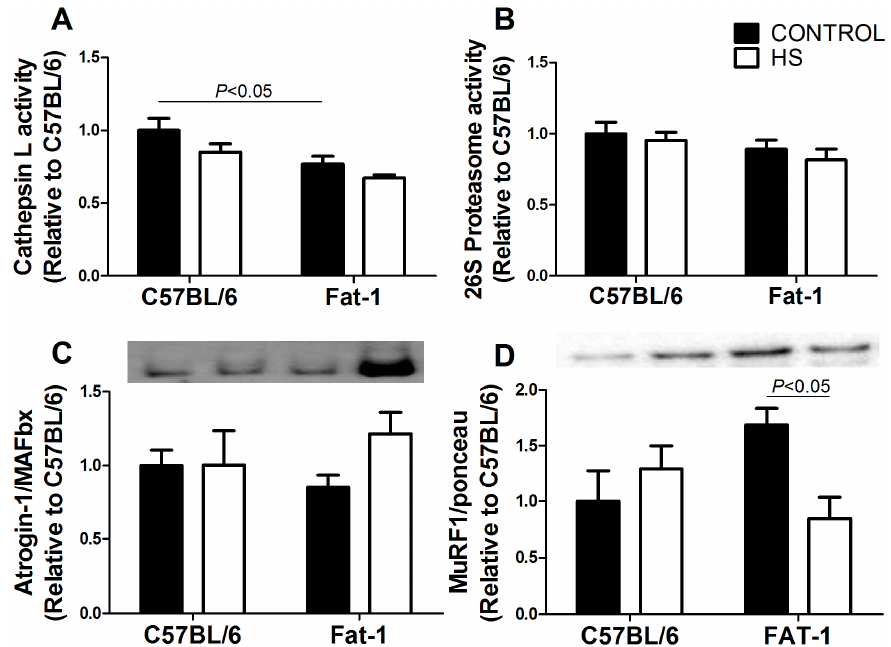
Figure 3. ( A ) Cathepsin L activity in the gastrocnemius muscle of the four groups studied (C57BL/6, C57BL/6 + HS, Fat-1, Fat-1 + HS). ( B) 26S proteasome activity in the gastrocnemius muscle. ( C ) atrogin-1/MAFbx and D. MuRF-1 content in soleus muscle. Values are presented as mean ± SEM on the basis of total protein loading as indicated by the Ponceau S measurement ( C,D ) and expressed relative to